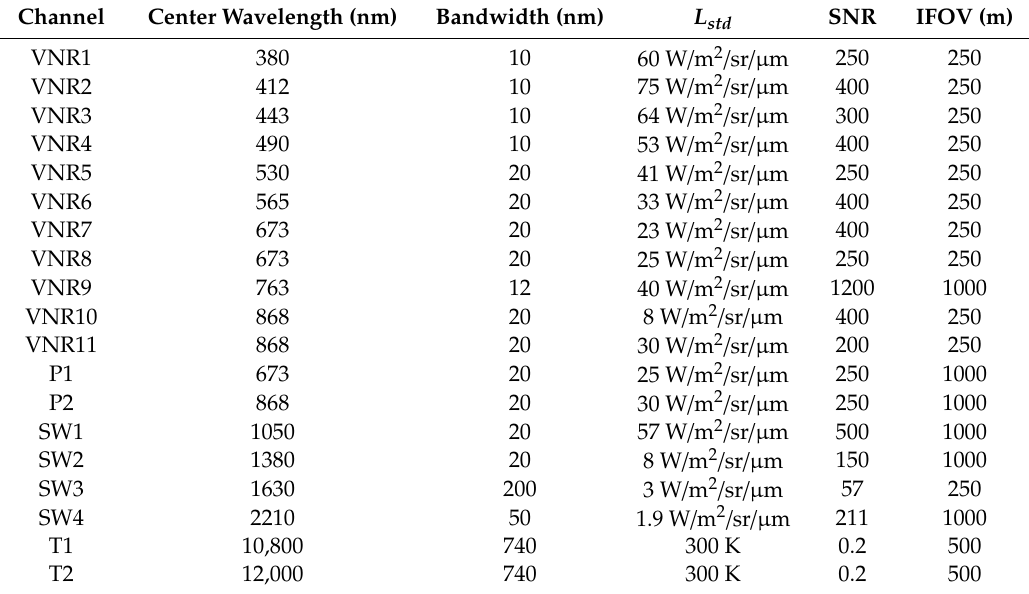
Table 2. Specifications of the SGLI channels.